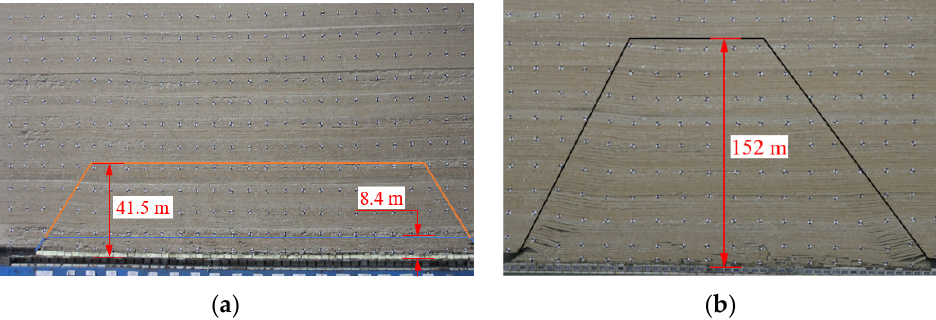
Figure 6. Development characteristics of overlying strata fractures. ( a ) PCFM; ( b ) Caving mining.